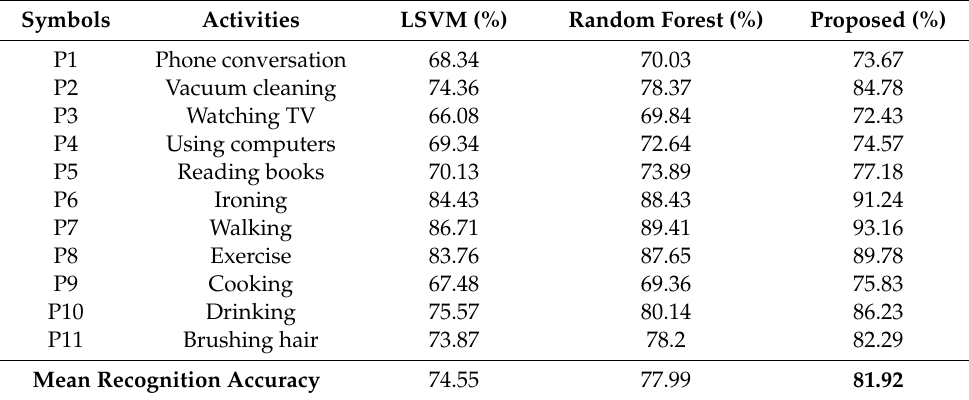
Table 1. IM-WSHA dataset applied over the proposed classifier and over well-known statistical